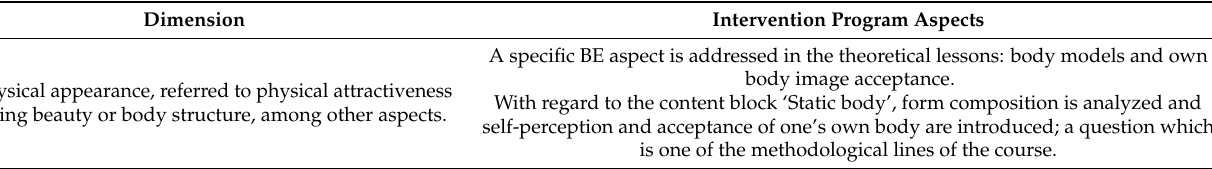
Table 2. Correspondence between the questionnaire dimensions and the intervention